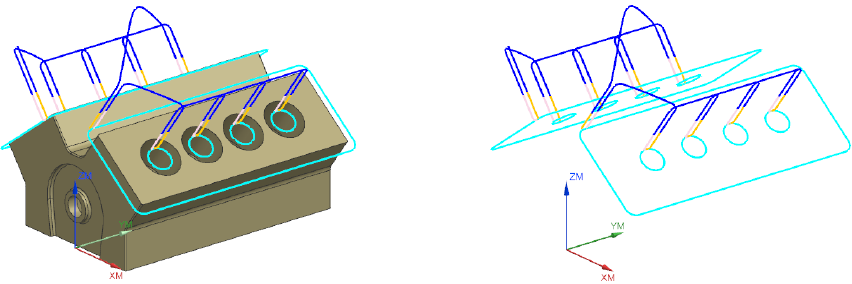
Figure 6. Cutting and non-cutting motions on the deburring toolpath.